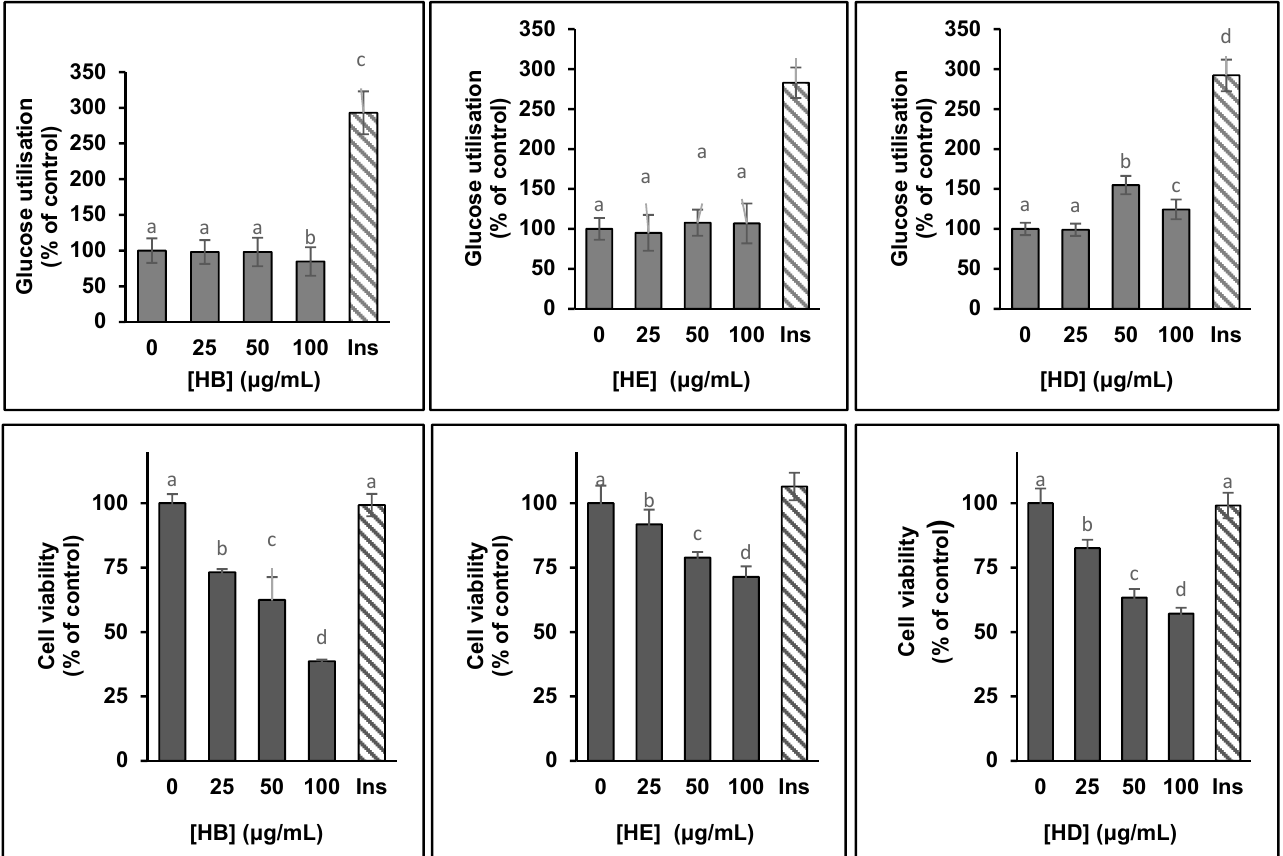
Figure 10. Effects of H. arborescens leaf extracts on glucose utilization in L6 cells and their corresponding effects on the L6 cell viability (MTT cytotoxicity) compared to the untreated cells. (Data are expressed as % of control ± SD, n = 3). HB—Blanched; HE—Ethanol and HD—Aqueous extracts; Met—Metformin. Mean separation by SD ( p < 0.05). Set of bars with different alphabets are significantly different.